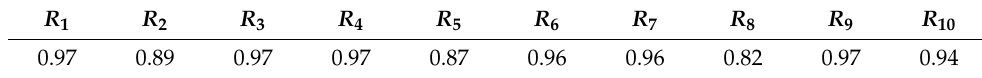
Table 2. Values of the Pearson’s correlation coefficients R m